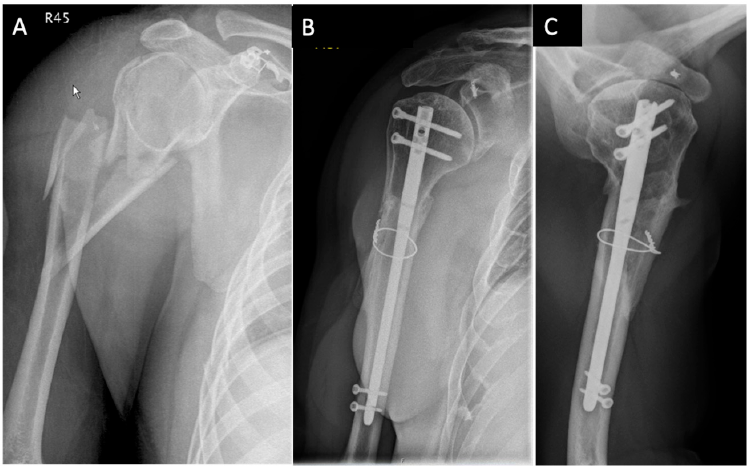
Figure 3. Example of surgical treatment with nailing and a metaphyseal cerclage: ( A ) Anterior– posterior X-ray image of an extended D3 fracture according to the Stedtfeld classification of a 43-year-old man after high energy trauma. ( B ) Anterior–posterior X-ray image 1 year after treatment with nail osteosynthesis and metaphyseal stabilization by a cerclage. ( C ) Axial X-ray image one year postoperative.